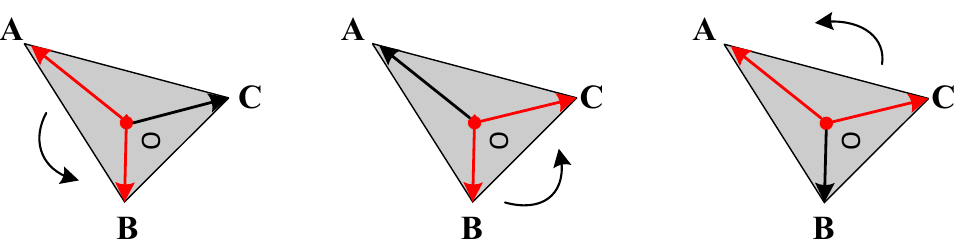
Figure 4. Rotational convolution schematic. A , B , C represent the three vertices of the triangle, O is the center point of the triangle, and the curved arrow outside the triangle represents two adjacent angle vectors for convolution operation.